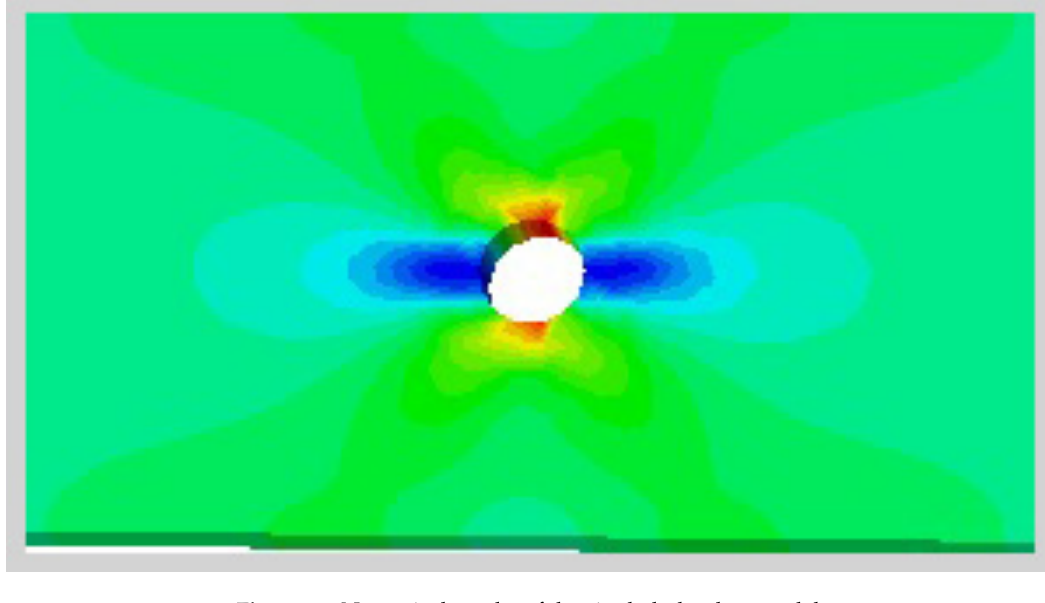
Figure 6. Numerical results of the single-hole-plate model.